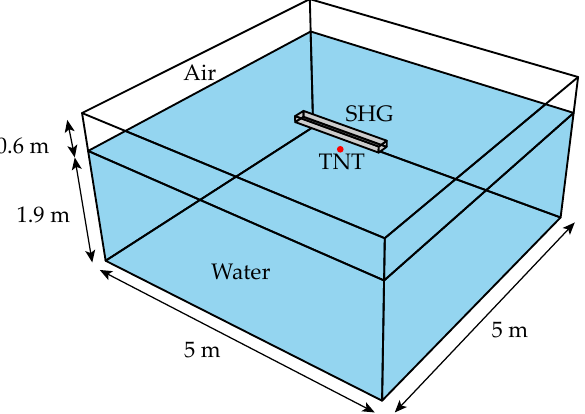
Figure 2. Arrangements diagram of underwater explosion simulation.